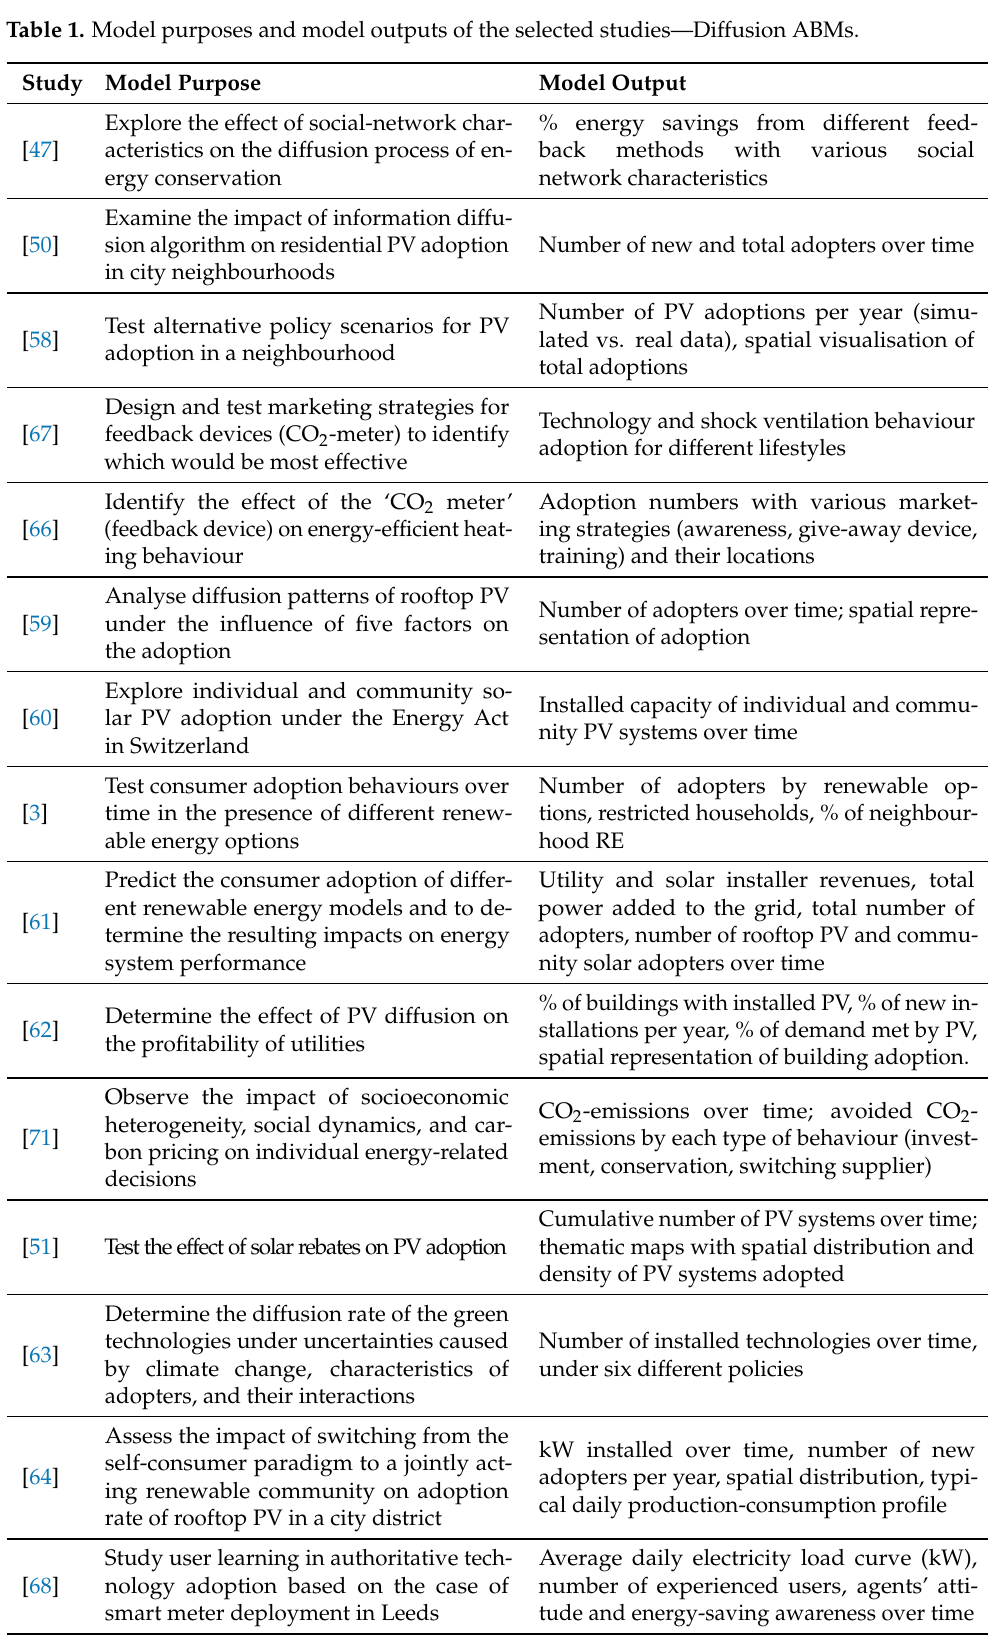
Table 1. Model purposes and model outputs of the selected studies—Diffusion